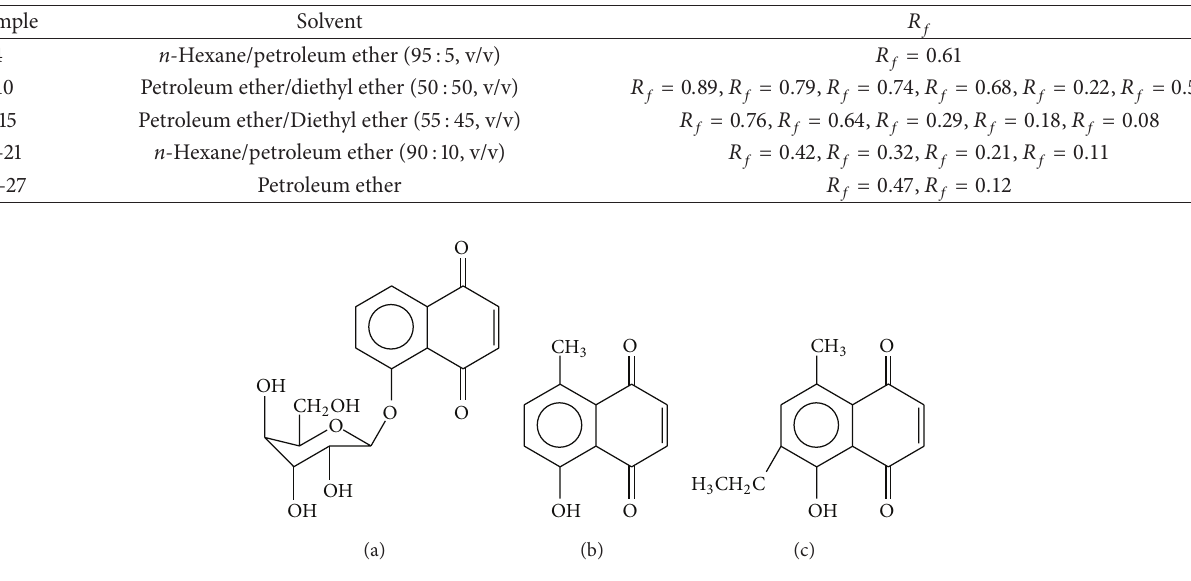
Figure 2: Chemical structures of the extracted dye from the walnut shells with different solvents: (a) 𝑛 -hexane/petroleum ether (90:10, v/v), = 0.32 , (b) petroleum ether/diethyl ether (50:50, v/v), 𝑅 𝑅 𝑓